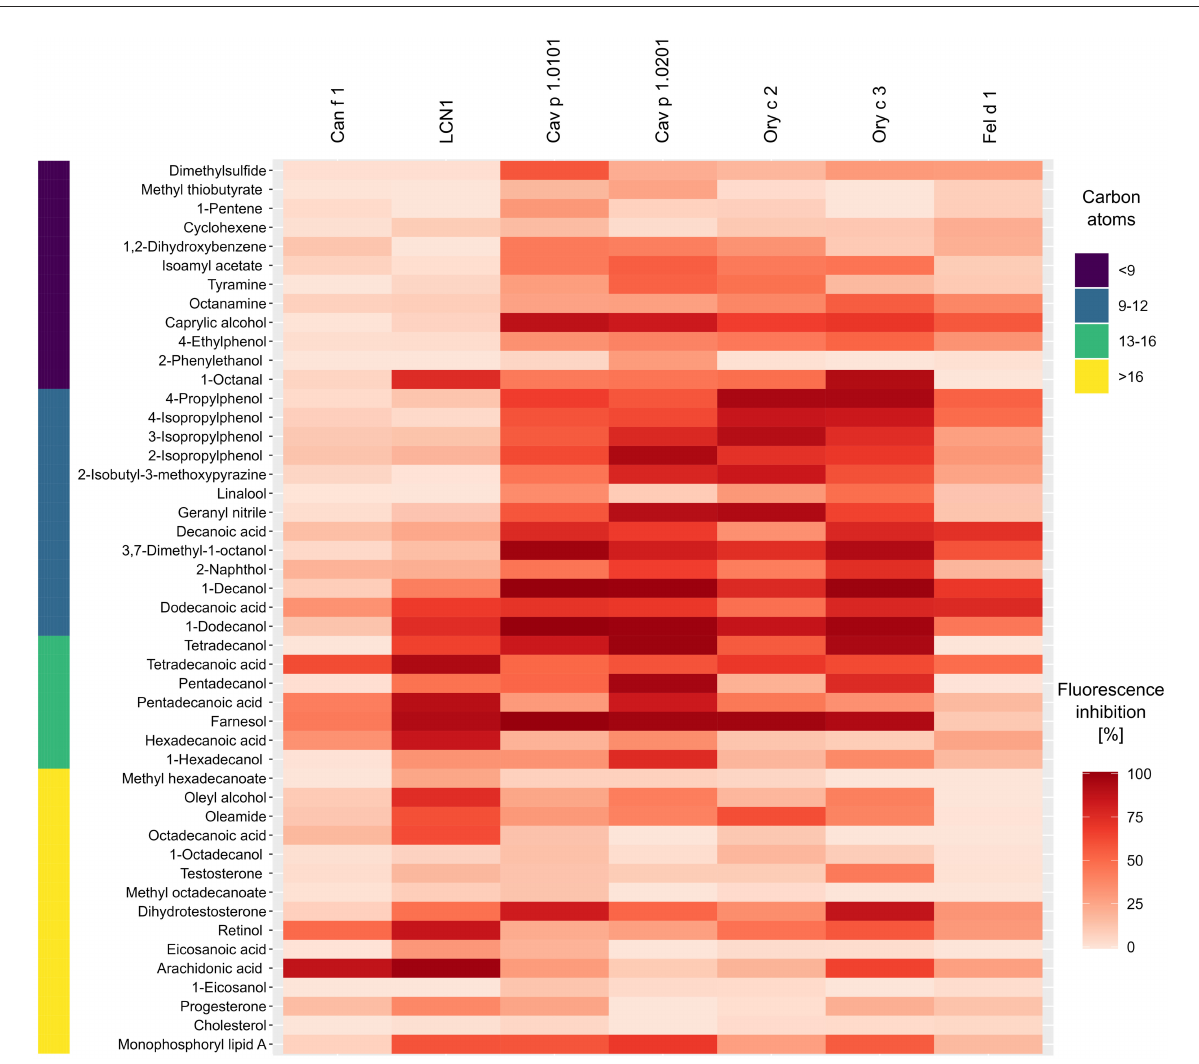
FIGURE9 Heat map highlighting universal ligands with high affinities toward four lipocalin and two secretoglobin mammalian respiratory allergens and human LCN1 from dark (high affinity) to faint red (low affinity). Bar on the left represents the number of carbon atoms for each ligand in dark violet < 9, blue 9–12, green 13–16 and yellow > 16. The heat map was created using mean fluorescence inhibition ( n = 2) of 5 µ M allergen-fluorochrome complexes by 50 µ M (100 µ M for Fel d 1) of forty-seven competitive